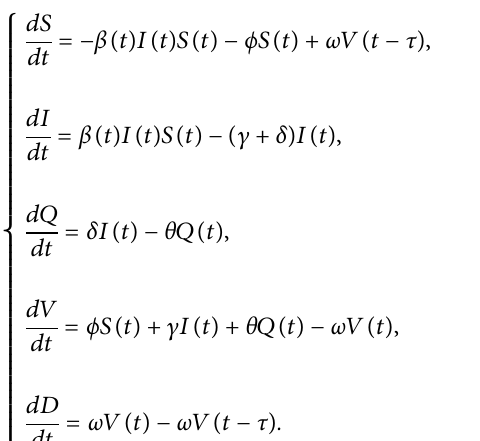
Figure 6: Comparisons between MalSEIRS, SEIRS, SIQDV, and SLBQR models. (a) MalSEIRS vs SEIRS [8]. (b) MalSEIRS vs SIQVD [15]. (c) MalSEIRS vs SLBQR [14].